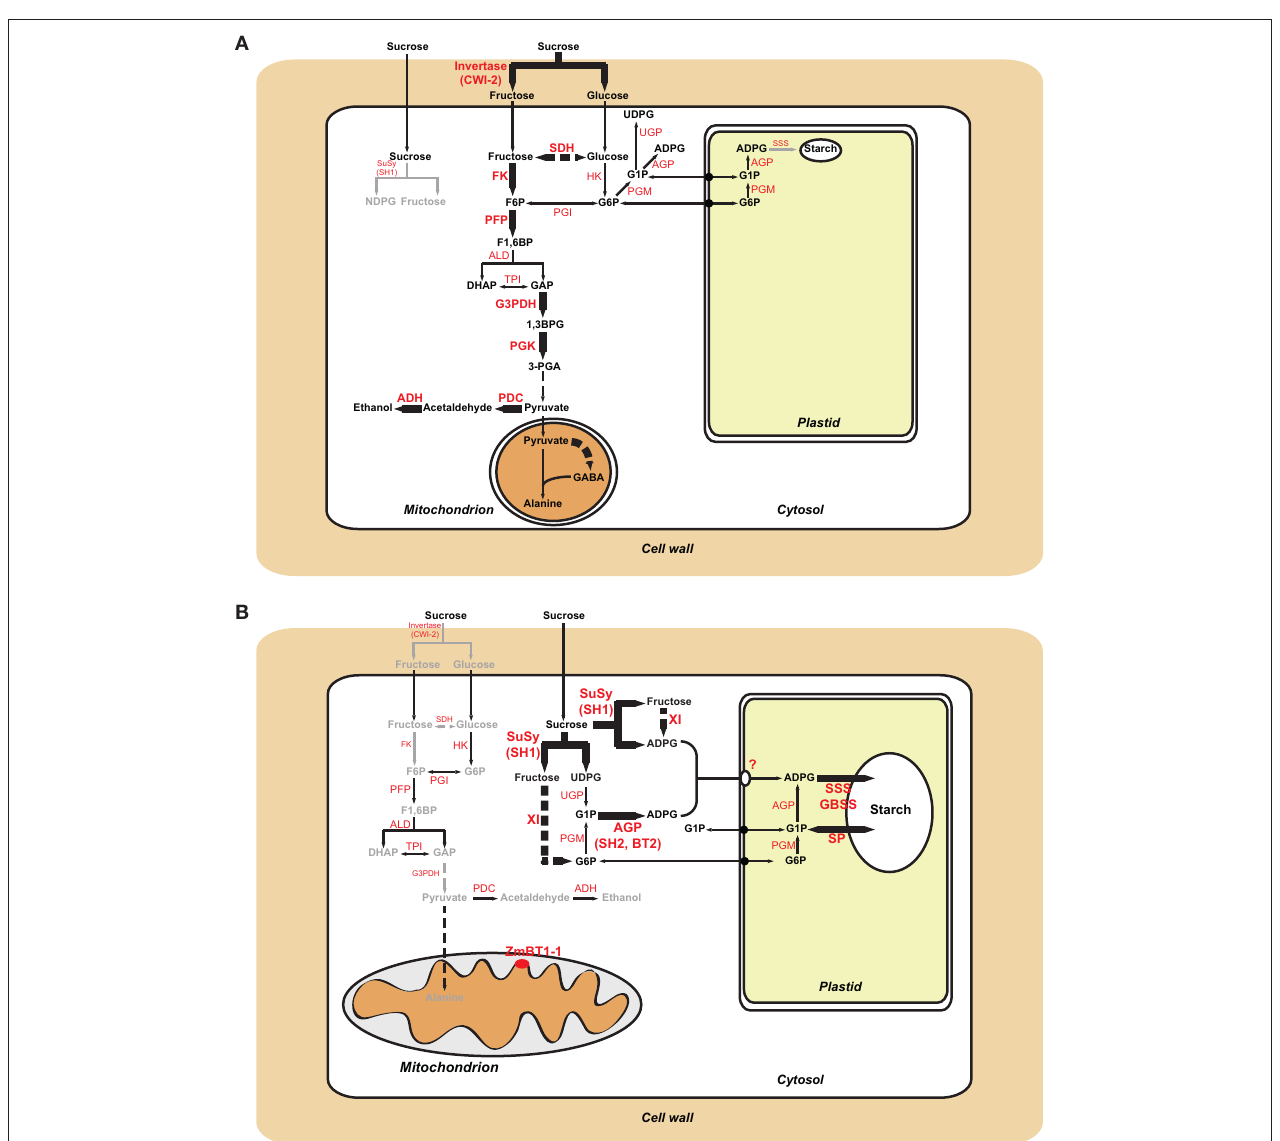
FIGURE 9 | Metabolic schemes illustrating sucrose metabolism pathways in maize endosperms. Panel (A) illustrates differences between Zmbt1-1 and WT endosperms. Enzymatic activities and pathways that are up-regulated in Zmbt1-1 endosperms are highlighted with large letters and thick arrows, respectively, whereas enzymatic activities and pathways that are down-regulated in Zmbt1-1 endosperms are highlighted with small letters and gray arrows, respectively. Panel (B) illustrates differences between Zmbt1-1 and Zmbt1-1::MitTPr- 1 TP-ZmBT1-1 endosperms. Enzymatic activities and pathways that are up-regulated